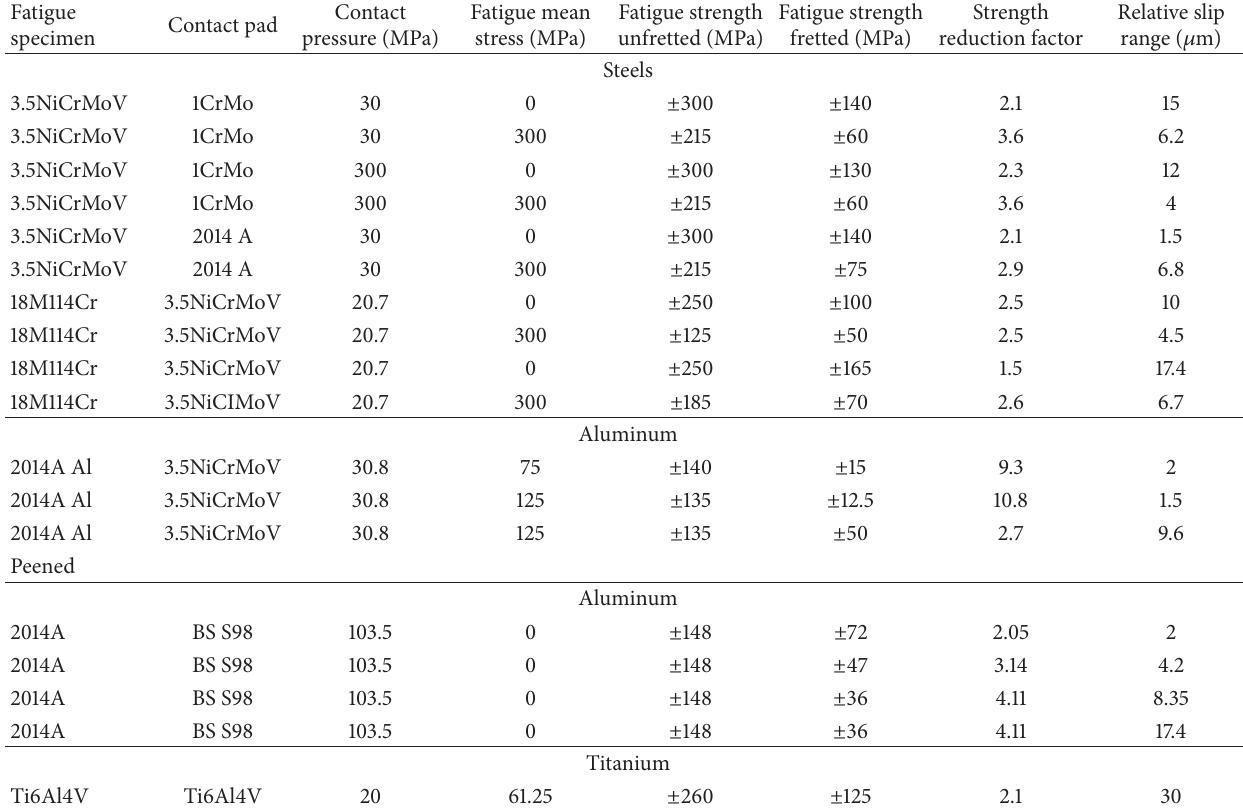
Table 1: The reduction coefficient of fretting fatigue life for some engineering alloys